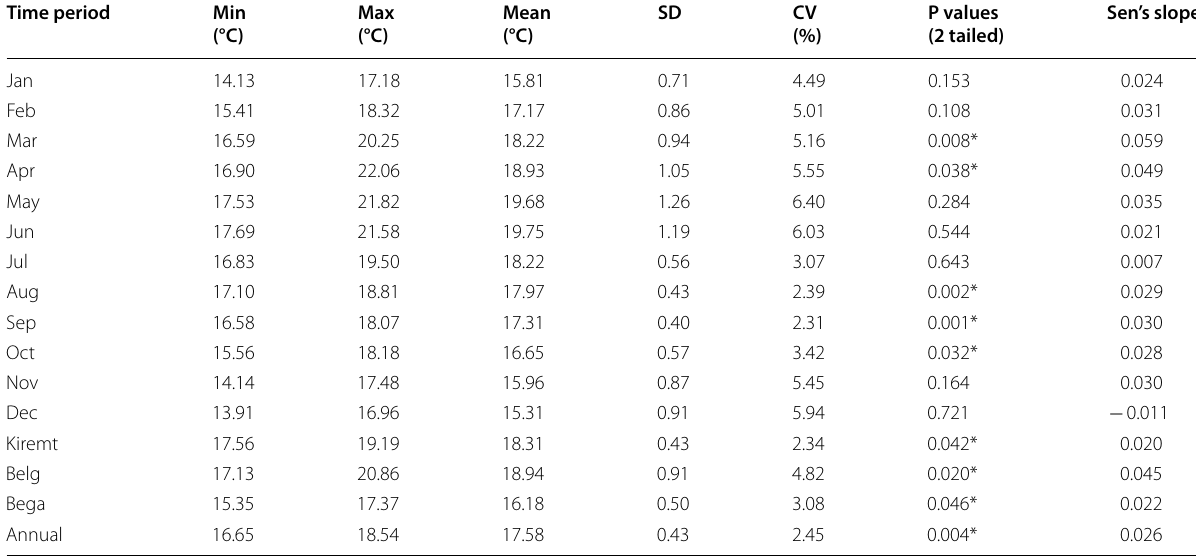
* Statistically significant (P